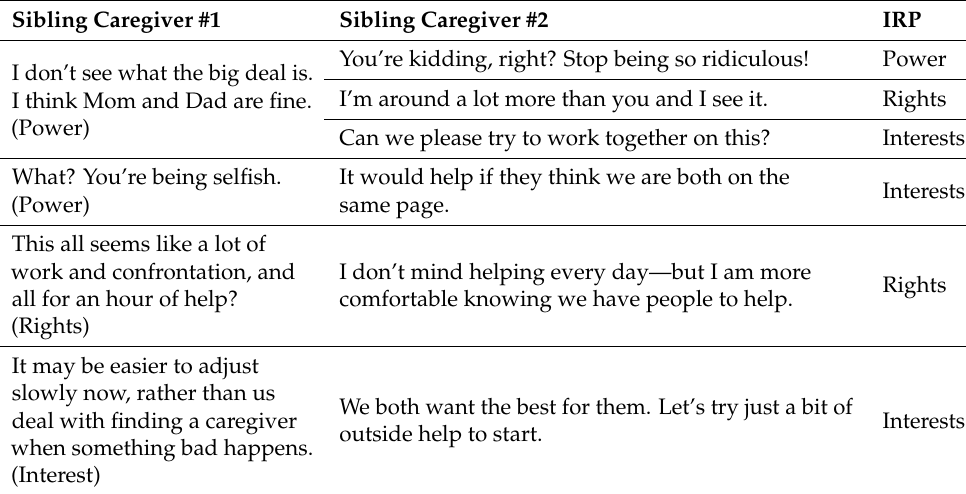
Table 1. Resulting